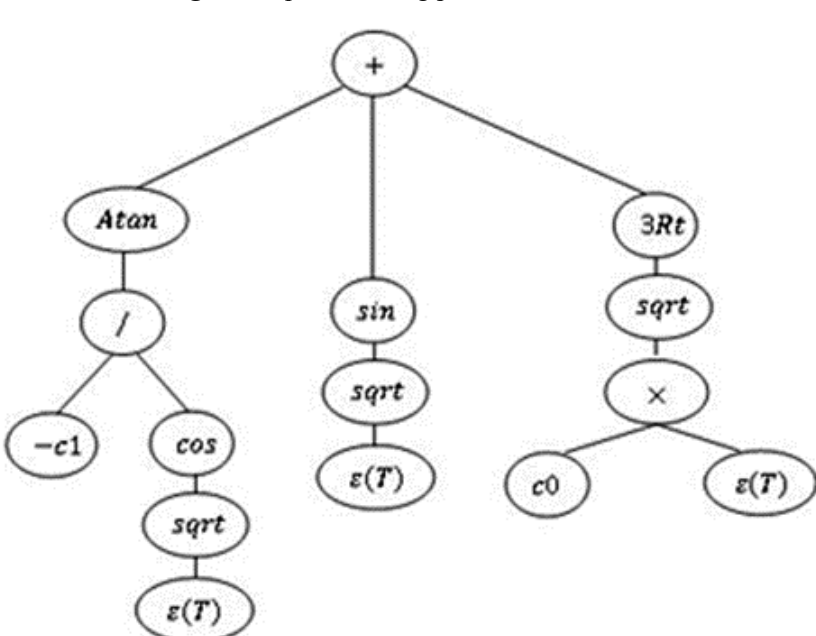
Fig. 6. Tree schematic of model calculated by genetic